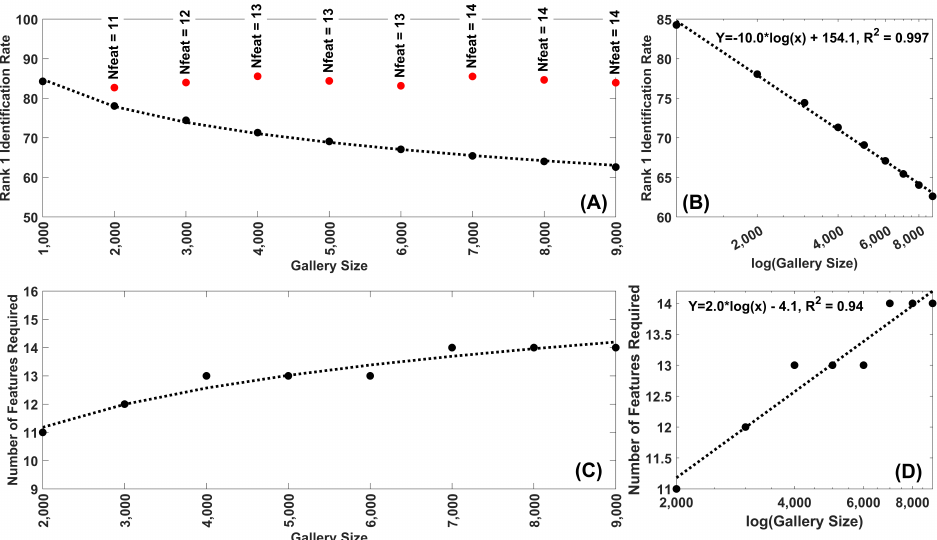
Figure 6. ( A ) Rank-1 IR as a function of gallery size for FaceNet features. Each dot represents the mean of 30 repetitions. The black dots are the Rank-1 IR for 10 features for gallery sizes from 1000 to 9000 in 1000 size steps. The red dots represent the Rank-1 IR for feature numbers greater than 10 which are chosen to produce a Rank-1 IR most similar to that for 10 features and 1000 subjects. ( B ) Same data as ( A ) plotted on a log(Gallery size) scale. Note the fit of the decline to a linear function of log(Gallery Size), with an r 2 = 0.997. ( C ) Plot of the number of features required for gallery sizes greater than 1000 to match the Rank-1 IR for 10 features, 1000 subjects. ( D ) Same data as ( C ) plotted on a log(Gallery size) scale. Note the fit of the increase to a linear function of log(Gallery Size). In this case a linear equation in log(Gallery Size) was able to match the results quite well ( r 2 =